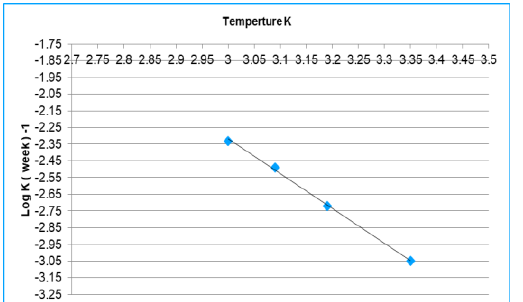
Figure 15. Arrhenius plot of freeze dried ATR nanosuspension for determination of degradation rate constant at 25°C